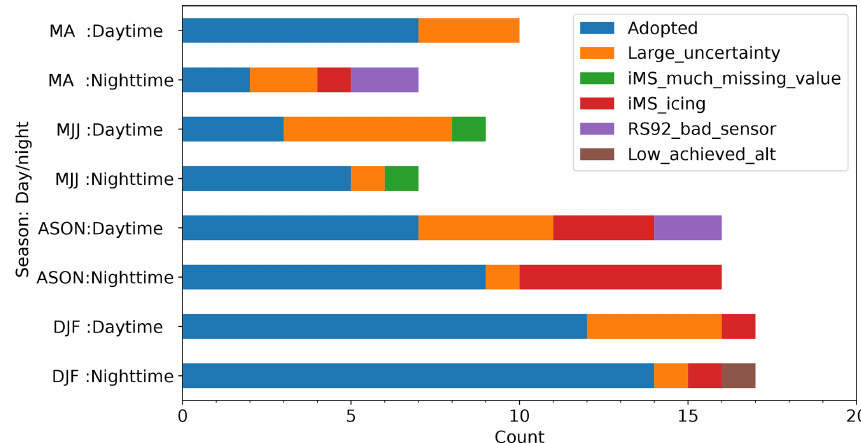
Figure 14. Major factors in the data screening. The term “Adopted” is used for comparison.